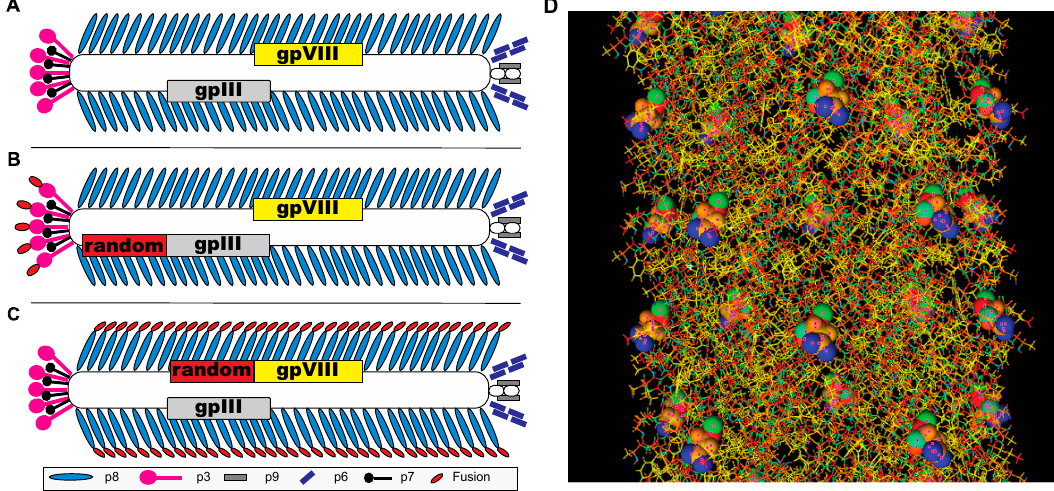
Figure 1. Filamentous phage display libraries. Schematic representation of type-3 and type-8 phage display libraries on the parent fd-tet bacteriophage vector. Each phage library is composed of a collection of phages with a randomized peptide fusion (red) displayed on every copy of the p3 or p8 protein. ( A ) Wildtype fd-tet vectors composed of 4000 copies of the p8 major coat protein (blue) encapsulating a single stranded DNA genome. Ends of phage particles are enclosed by 4 minor coat proteins: p3 (pink), p6 (black), p9 (grey), and p7 (purple). ( B ) Display of fusion peptides (red) on every copy of the fd-tet p3 protein, present in 5 copies per phage. ( C ) Display of fusion peptides (red) on every copy of the fd-tet p8 protein, present in ~4000 copies, generating a library of phage particles with unique peptide landscapes for interaction with the environment. ( D ) Stick model diagram of an ~10 nm segment of a type-8 landscape phage. Fusion peptide sequences are displayed at the N-terminus of each copy of the p8 protein and modeled as spheres to demonstrate the unique landscapes generated by each particle.